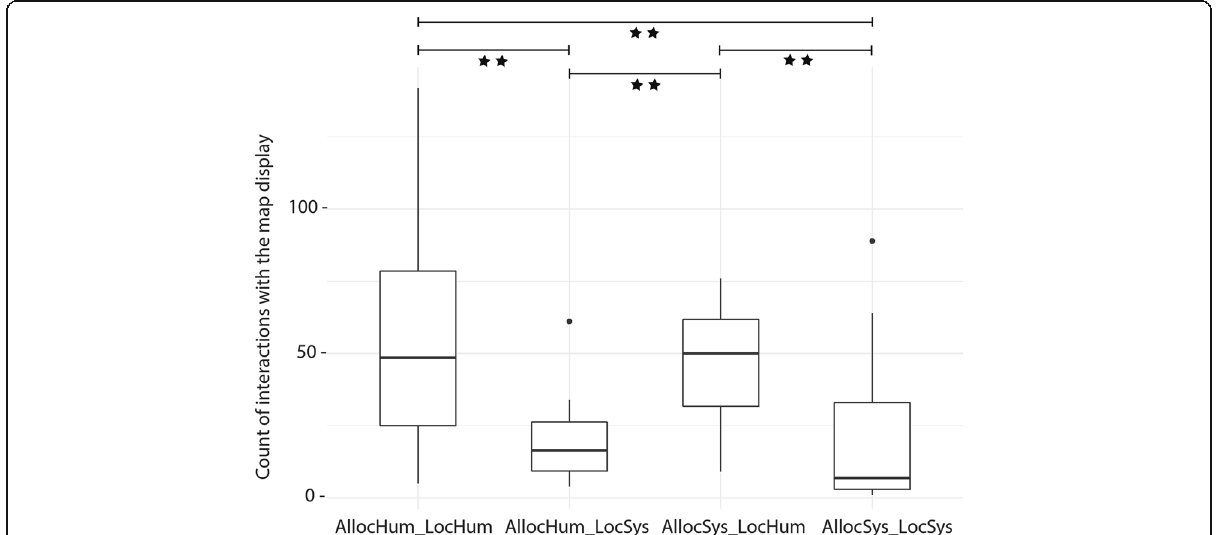
Fig. 7 Significant differences in counts of interactions (zoom, pan, rotate) with the map display during Phase 1 across groups (statistically significant difference between groups, ** p <0.01). Black dots indicate outliers